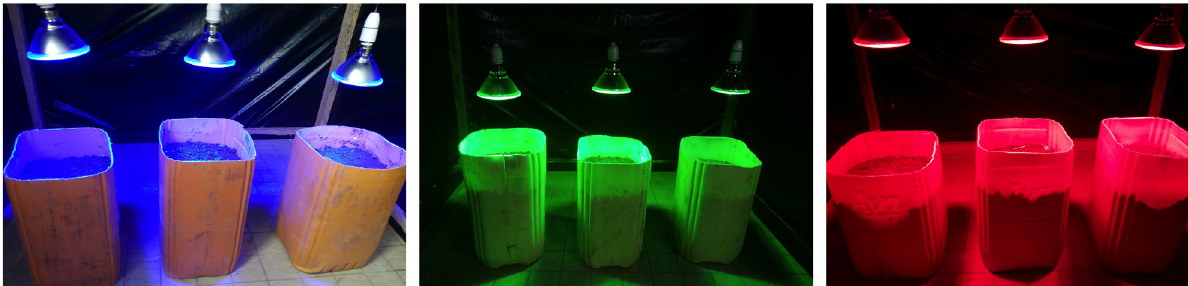
Figure 1: Pots and light treatment inside each